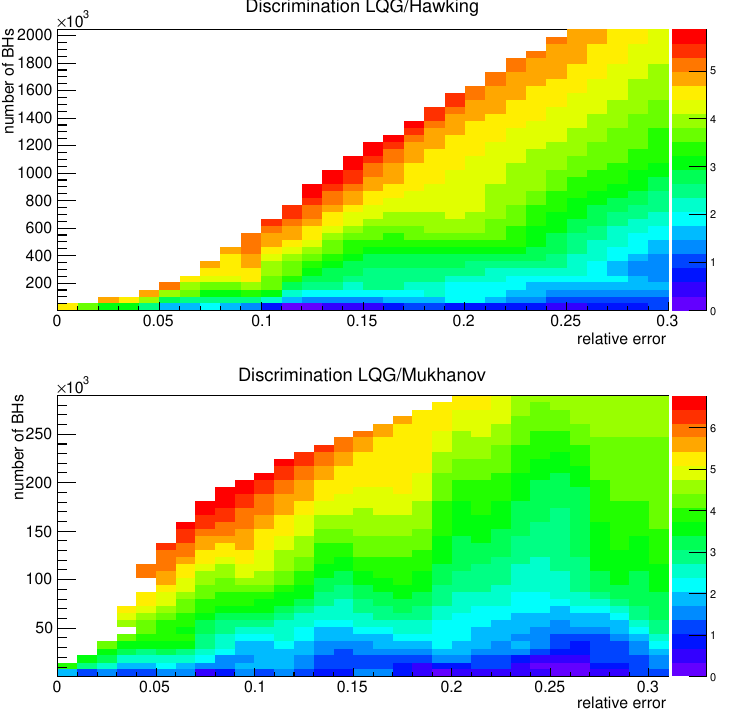
Figure 1. Number of BHs that would have to be observed as a function of the relative error on the energy measurement for different confidence levels (the color scale corresponds to the number of standard deviations). Upper plot: discrimination between loop quantum gravity (LQG) and the Hawking spectrum. Lower plot: discrimination between LQG and the Mukhanov–Bekenstein hypothesis [40]. From